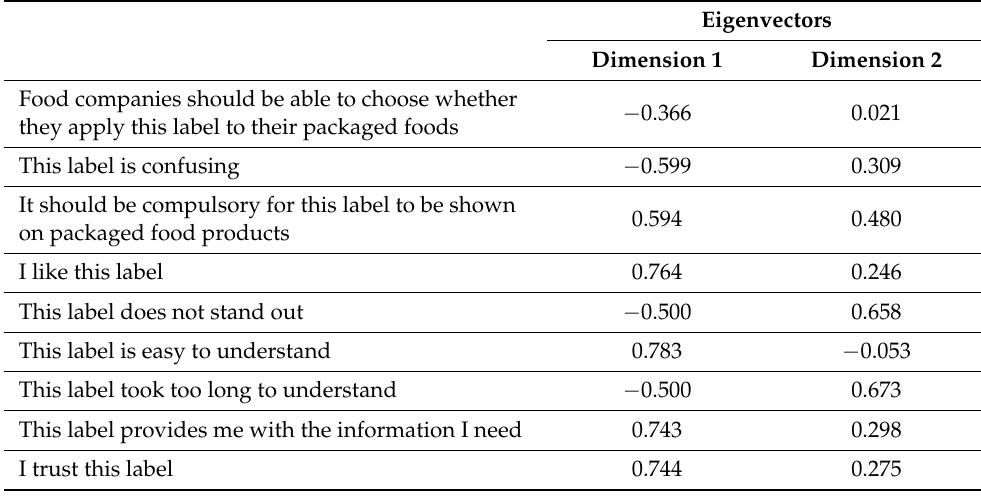
Table 5. Eigenvectors of each perceptions’ variable on the two dimensions from the principal component